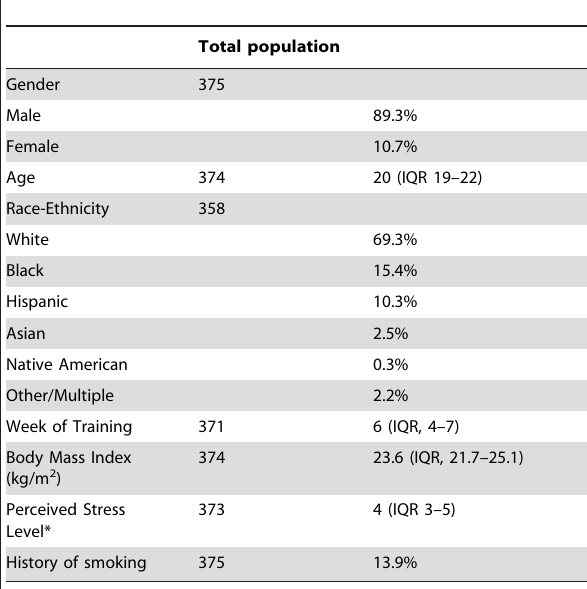
Table 1. Demographic information of trainees presenting with respiratory illness.